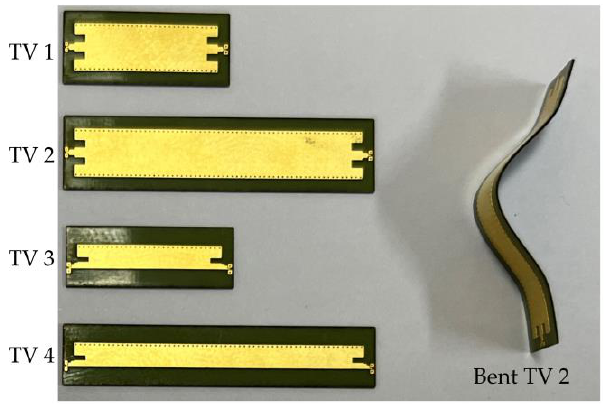
Figure 5. Fabricated TVs using FPCB manufacturing process.